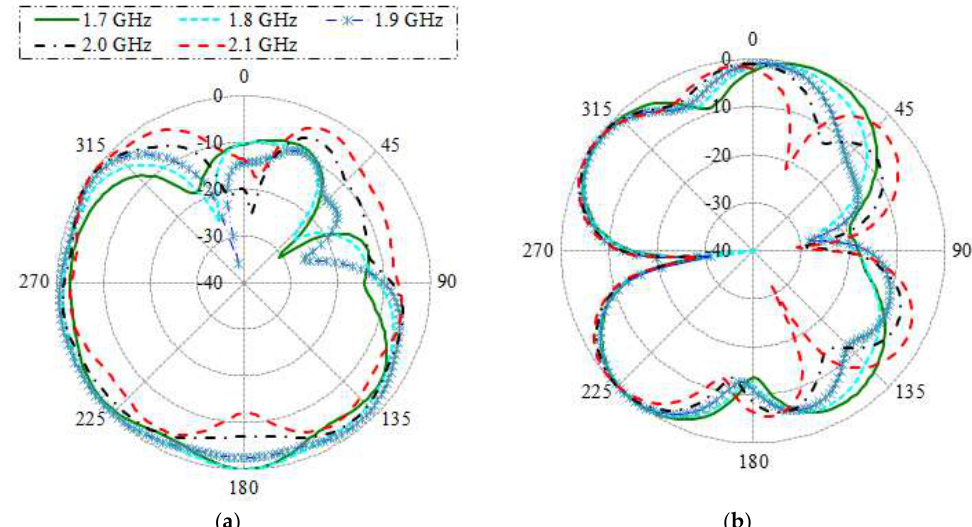
Figure 6. Measured radiation patterns at different frequencies (a) E-plane, and (b) H-plane.